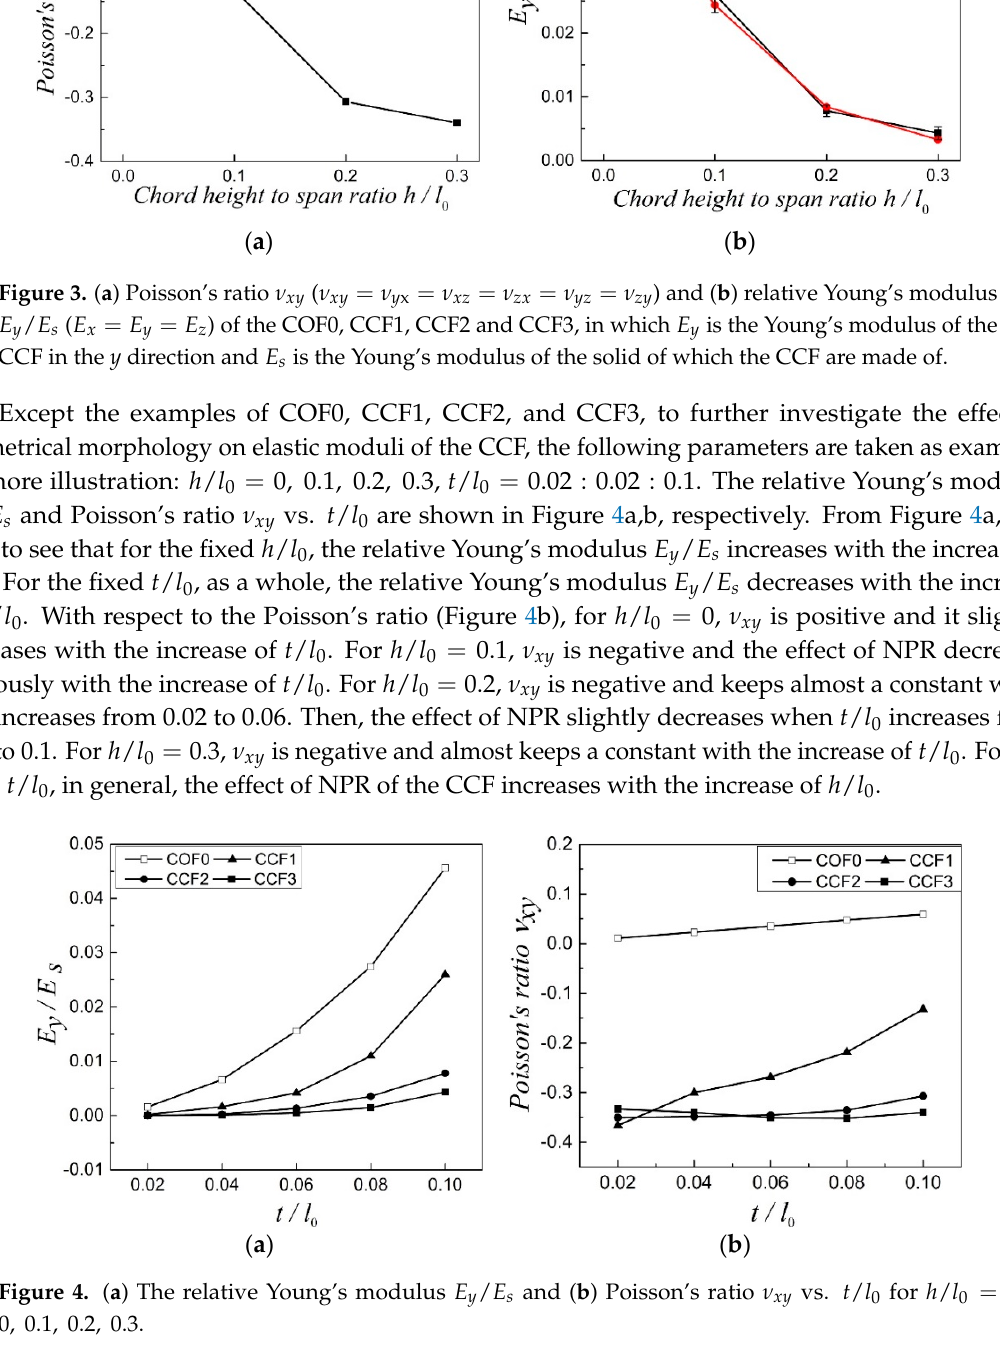
ν vs t l for 0 xy